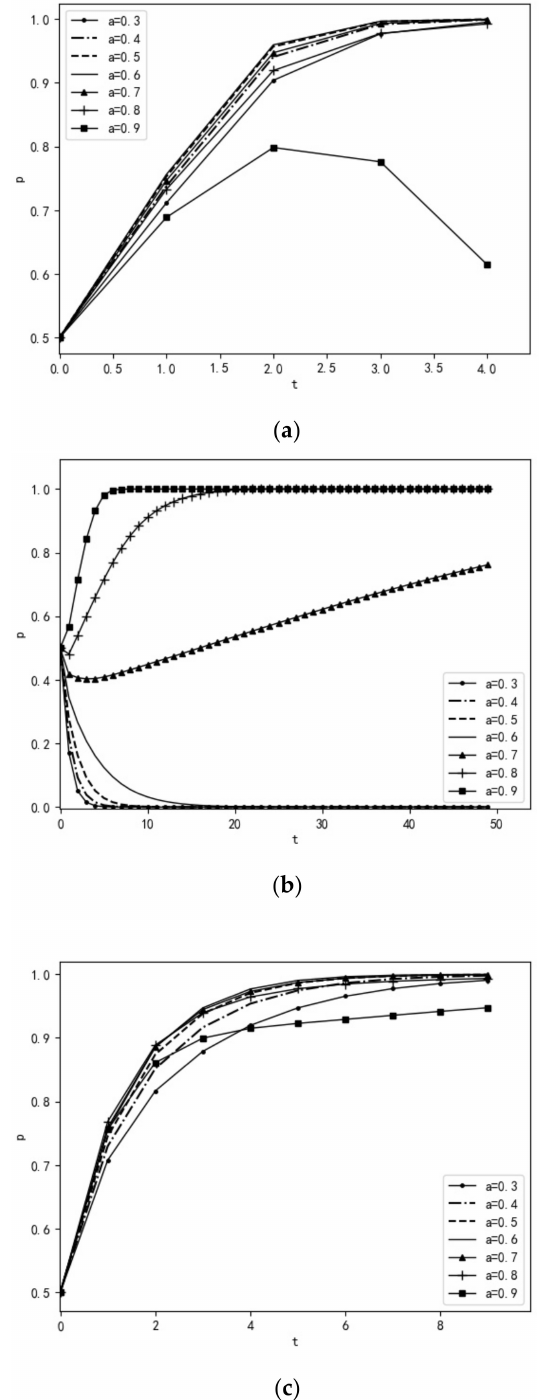
Figure 8. The impact of authenticity on tripartite evolution strategies. ( a ) The impact of authenticity on the local government. ( b ) The impact of authenticity on enterprises. ( c ) The impact of authenticity on the